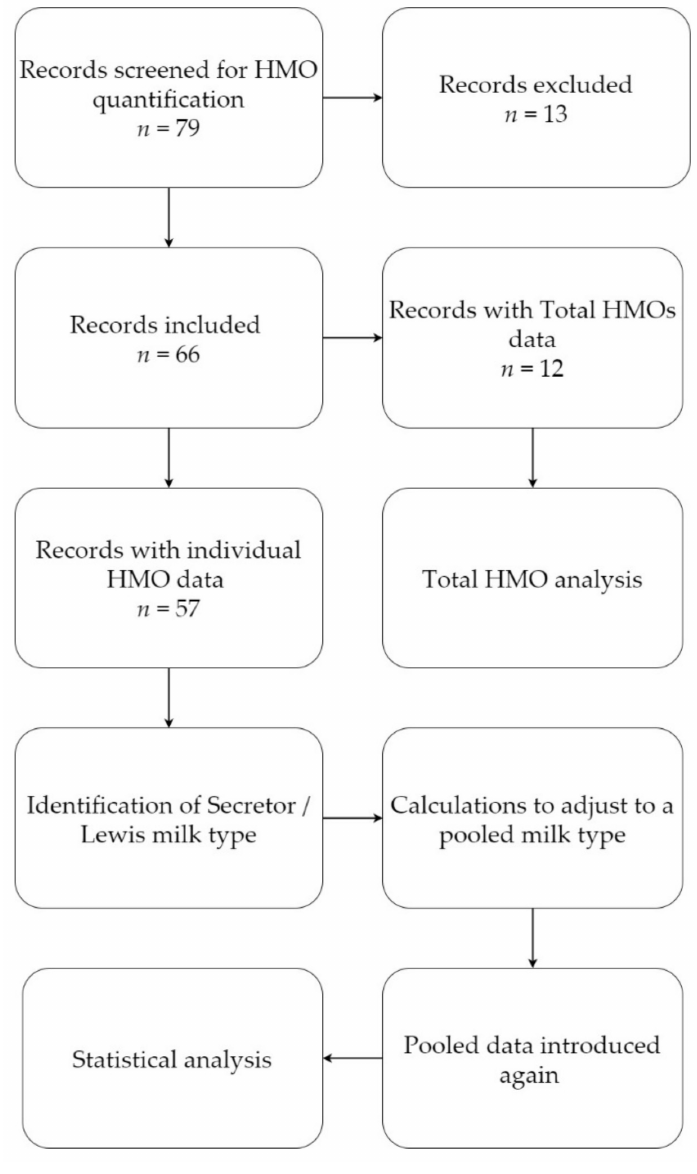
Figure 1. Flow chart of the